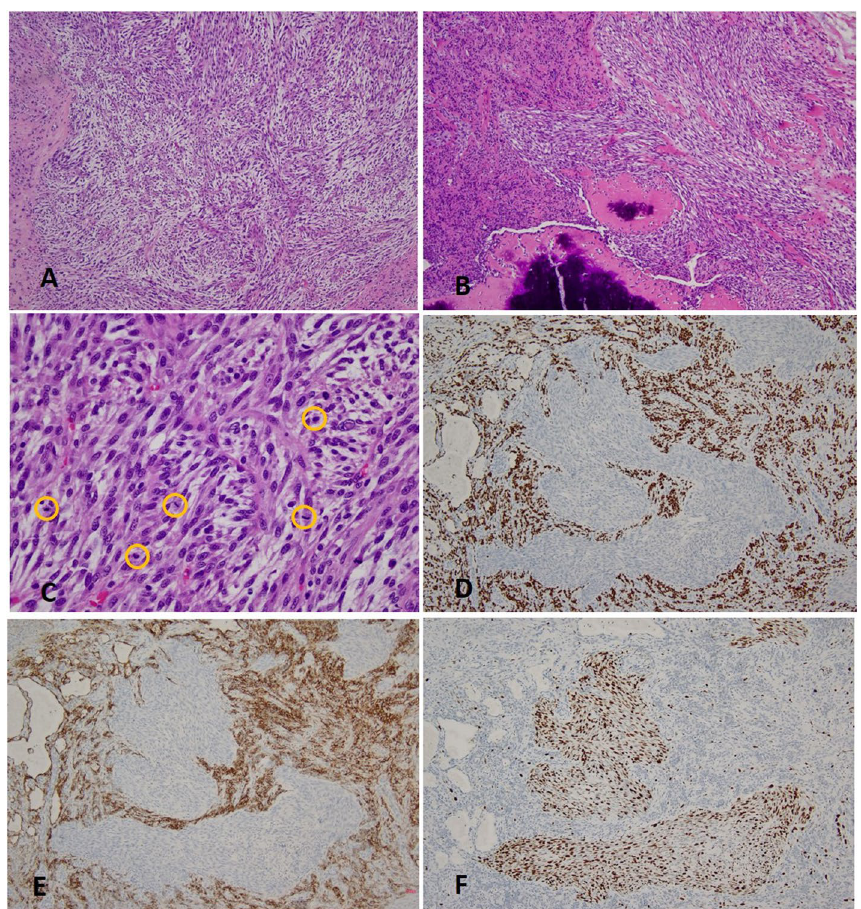
Fig. 3 Sarcomatoid area of the tumor. ( A ) The spindle cells arrange in interlacing pattern(H&E stain, intermix with the typical PSP component(in the left) and metaplastic bone can be seen at the bottom of the picture (H&E stain, monomorphic tumor cells show brisk mitotic activity(yellow circles, H&E stain, EMA ( E ), while the surrounding PSP cells are positive for both markers (